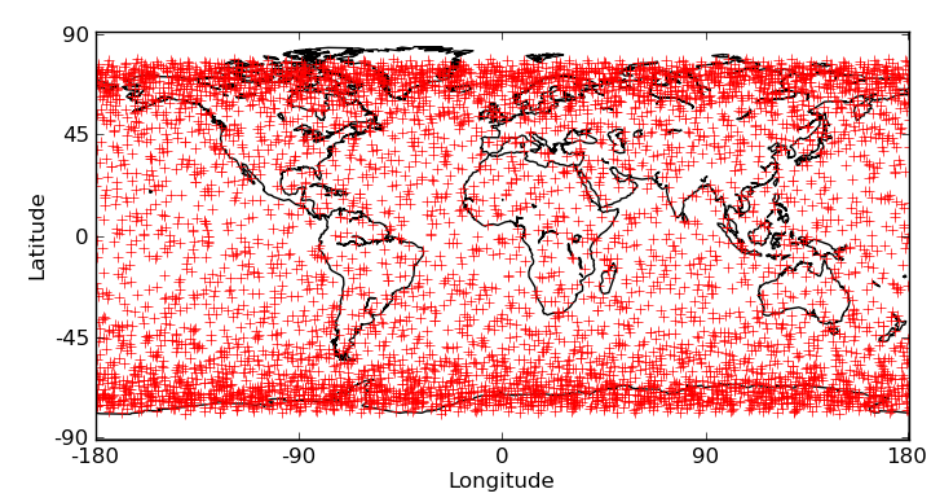
Figure 2. Distribution of realized SNO match-ups within 10 min for NOAA-18 AVHRR and AQUA MODIS in the period 2007–2009.